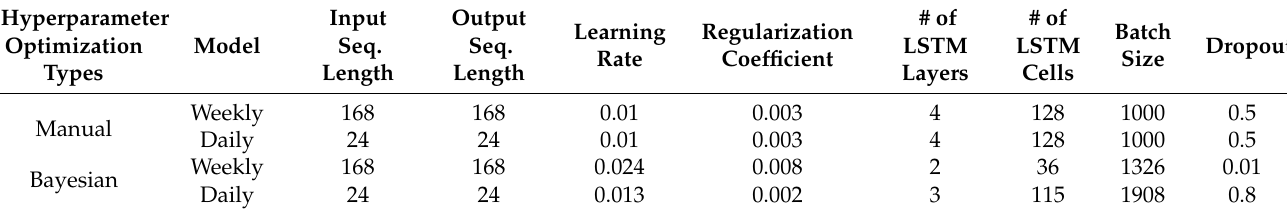
Table 7. Hyperparameter values with simulation